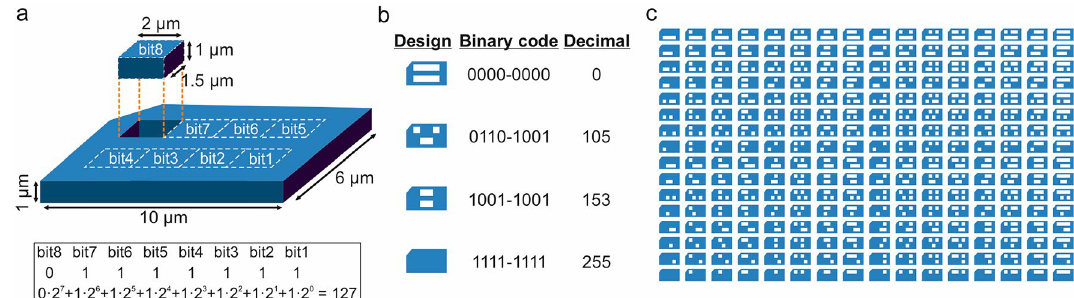
Figure 1. Designed barcodes. ( a ) Schematic of the barcodes comprising 2 rows of 4 rectangles areas representing bits. The presence of material in these areas indicates a ‘1’ and the absence indicates a ‘0’. A mark (cut) on the top left corner indicates the start of the reading position. ( b ) Representation of the physical design, and the corresponding binary and decimal codes for some of the tested devices. ( c ) Designed barcodes showing all possible encoded combinations, from 0 (top right) to 255 (bottom